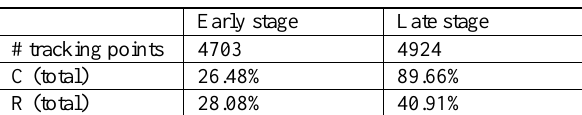
Table 2: Evaluation the completeness and correctness of the prediction based on the GPS-game dataset